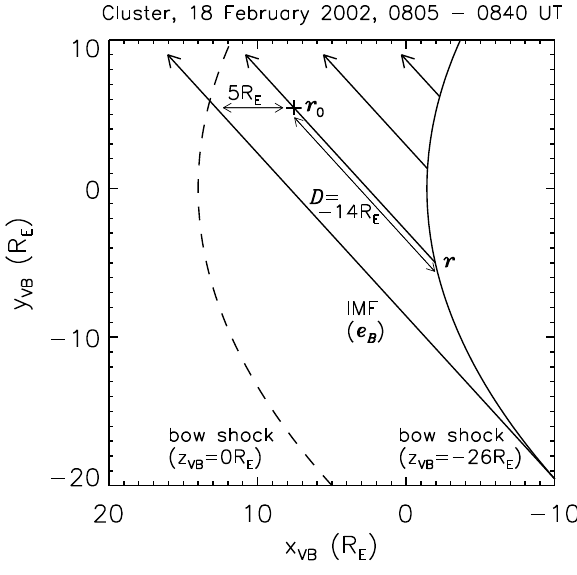
Fig. 2. Geometrical configuration of the foreshock wave observa- tion between 08:05 and 08:40 UT on 18 February 2002. The x-axis is aberrated to the solar wind direction. The xy plane is made by the solar wind and IMF direction, translated in the z direction to the location of Cluster 3 at z = − 26 R E . Bow shock at z =0 R E projected into z = − 26 R E is also present. r 0 , r , D and e B represent Cluster 3 location, the intersection of IMF line connected to the spacecraft at the bow shock, the distance between r 0 and r , and the unit vector of IMF orientation,